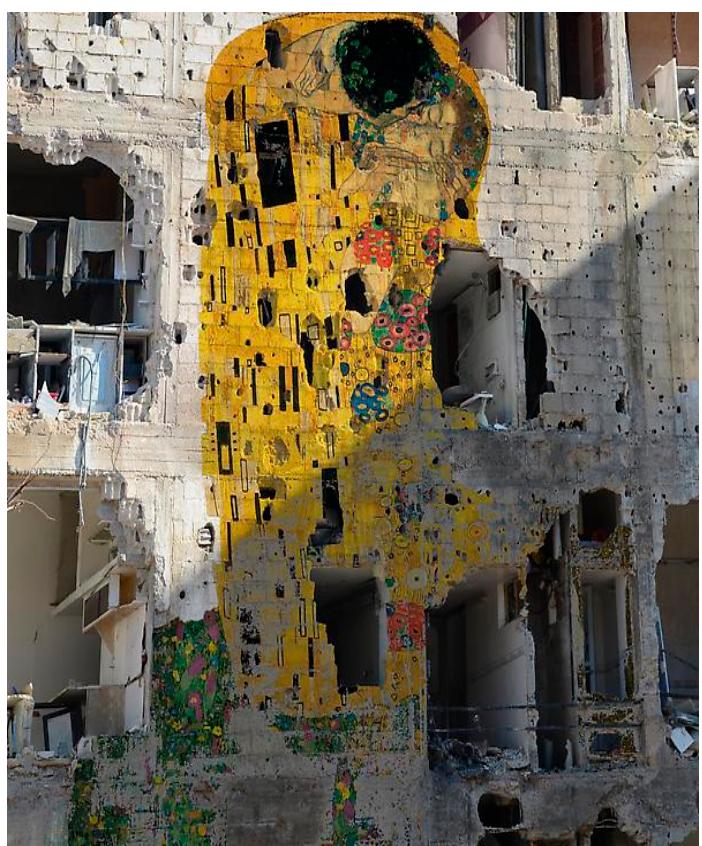
Figure 5. Tammam’s ‘Freedom Graffity’ (2013). (Digital Print.) Used by permission of the artist.